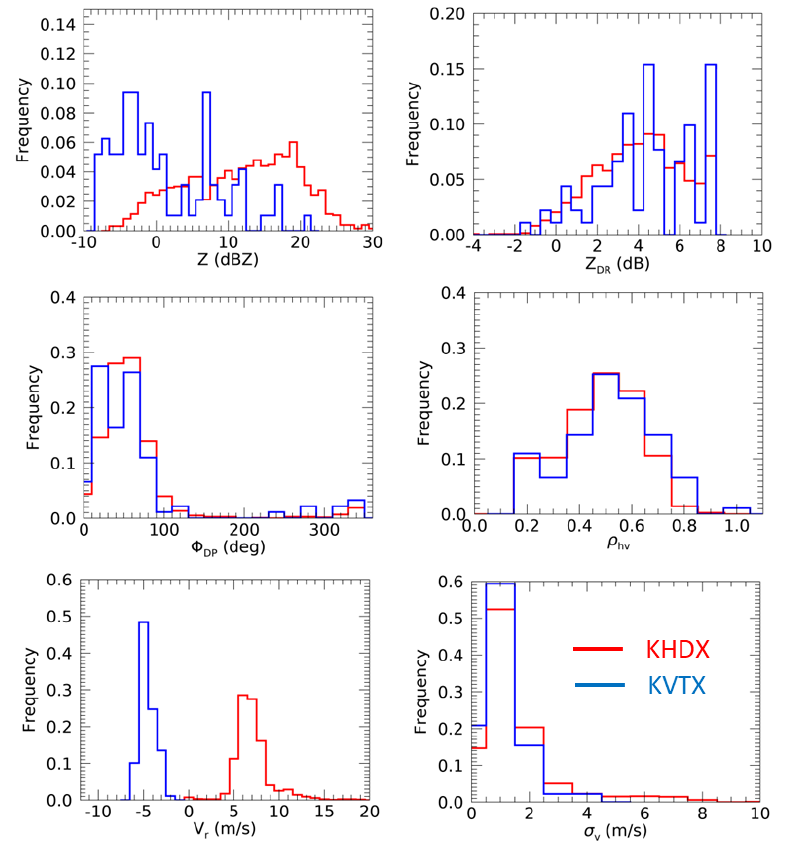
Figure 17. Histograms of the polarimetric variables. The red graphs stand for the New Mexico smoke plume (KHDX WSR-88D, el = 3.5 ◦ , and time is 00:43 UTC). The blue graphs are from the Los Angeles brush fire obtained with the WSR-88D, code name KVTX, el = 2.5 ◦ (time is 21:58 UTC). Date is June 17, 2017.